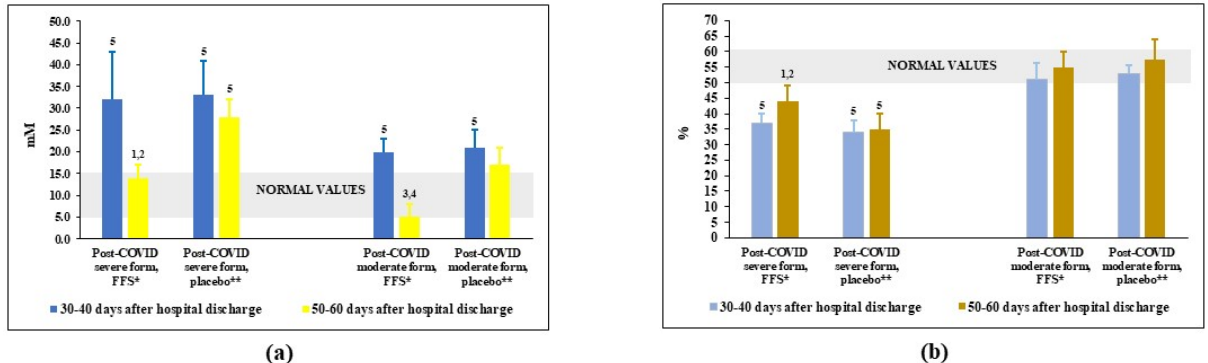
Figure 4. Plasma levels of (a) nitrites-nitrates and (b) plasma antioxidant capacity (AOA) in post- COVID period of the FFS and placebo groups. * FFS—Fermented fruit supplementation, 28 g for 20 days; ** Placebo-diluted 5% honey, 28 g for 20 days; Grey area covers normal range of values. 1 p < 0.01 versus post-COVID severe form, FFS; 2 p < 0,01 versus post-COVID severe form, before FFS supplementation; 3 p < 0.01 versus post-COVID moderate form, FFS; 4 p < 0.01 versus post-COVID moderate form, before FFS supplementation; 5 p < 0.01 versus donors.